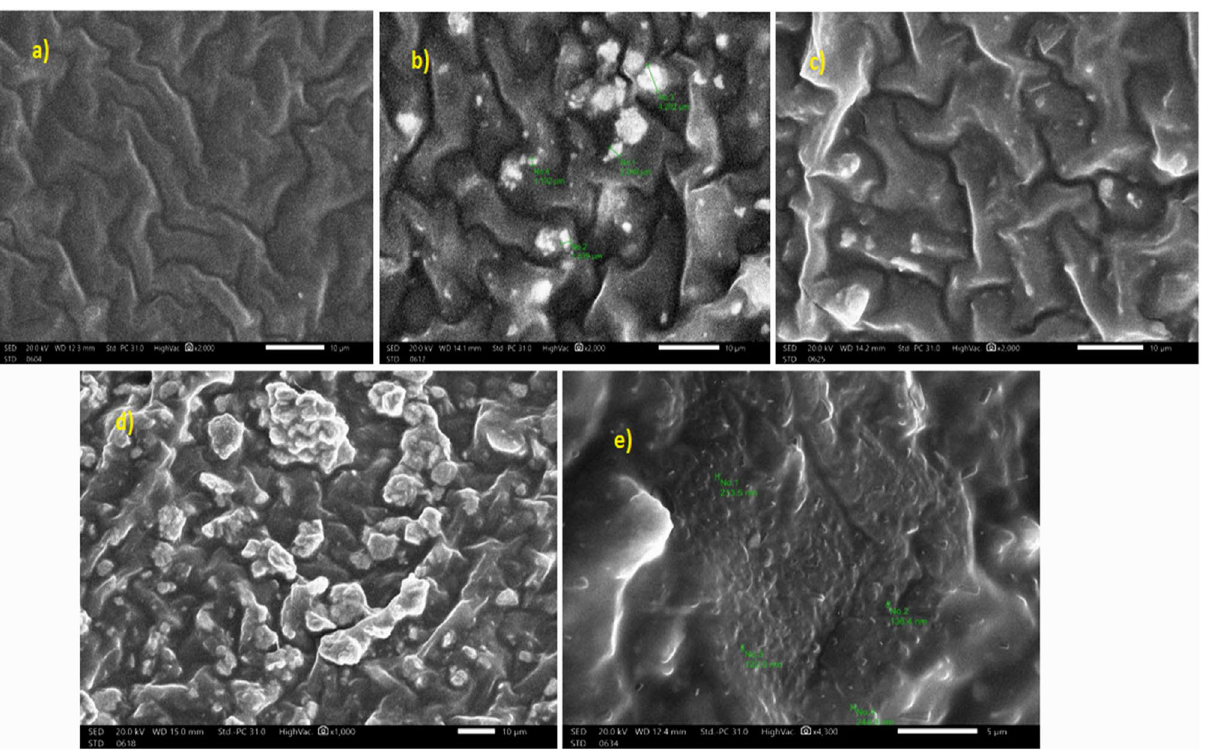
Figure 4. SEM image of ( a ) pure dimethyl polysiloxane (silicon rubber), ( b ) 20 wt% micro PbO sample, ( c ) 20 wt% nano PbO sample, ( d ) 50 wt% micro PbO micro, ( e ) 50 wt% nano PbO